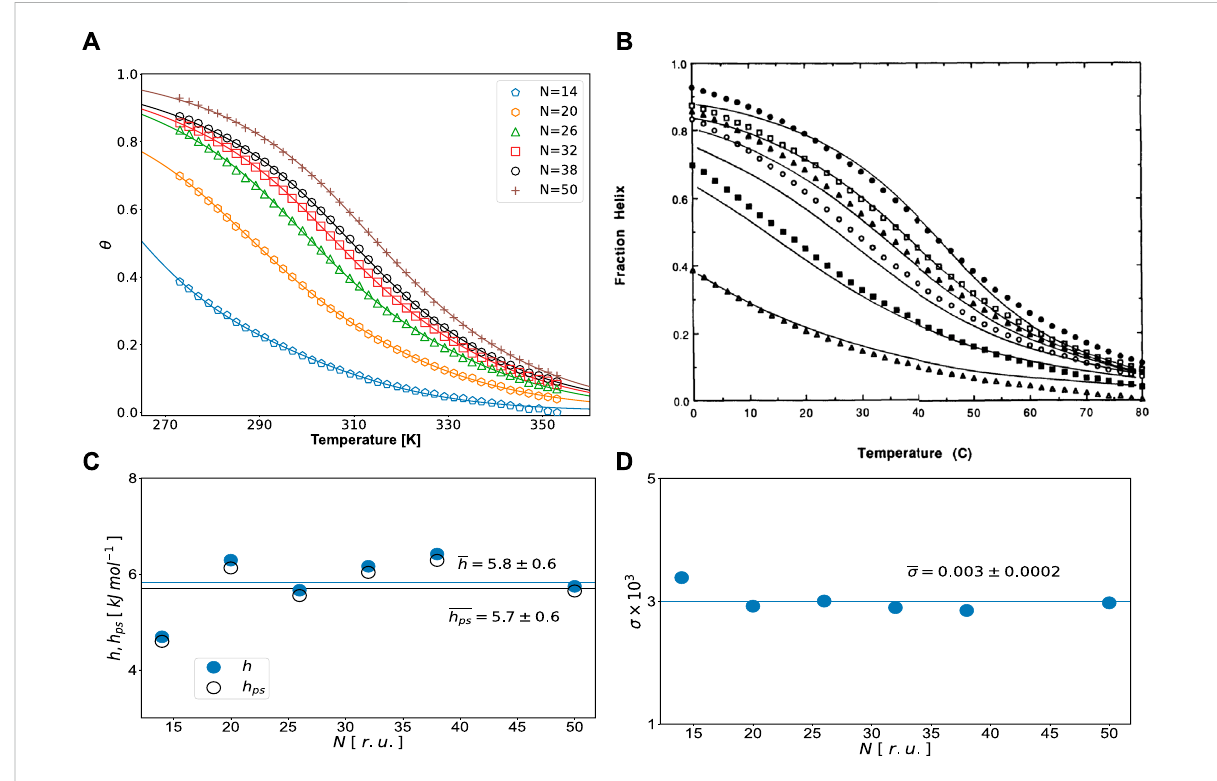
FIGURE 1 (A) Helicity degrees for different chain lengths ( N , r . u .). The data points (symbols) are taken from Scholtz et al. (1991). Solid lines are fi ts of Eq. 18 to experimental data. Fitting values are reported in Table 1: (B) fraction helix (helicity degree) data with original fi ts reproduced from Figure 3 of